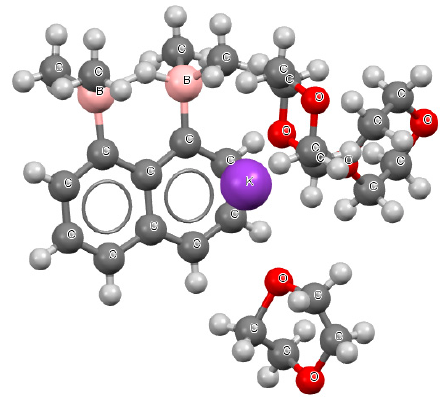
Figure 5. The fragment of the crystal structure of potassium ( μ 2 -hydrido-B,B')-naphthalene- 1,8-diyl-bis(dimethylborane) dioxane solvate (refcode